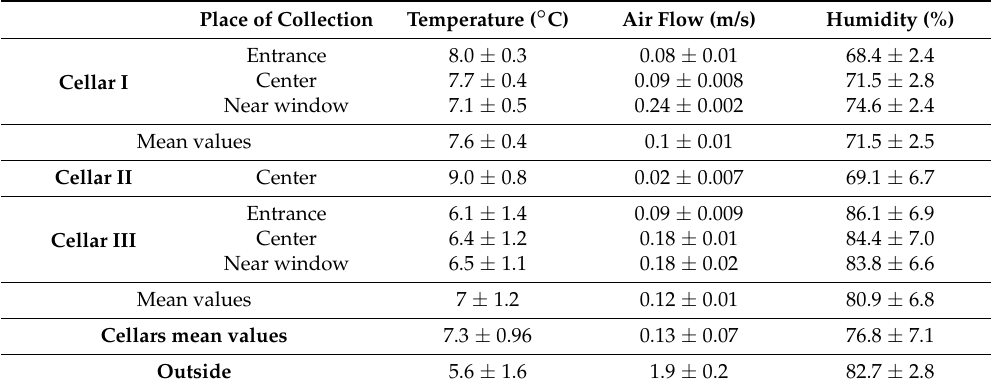
Table 1. Temperature, humidity, and air flow in the tested areas.